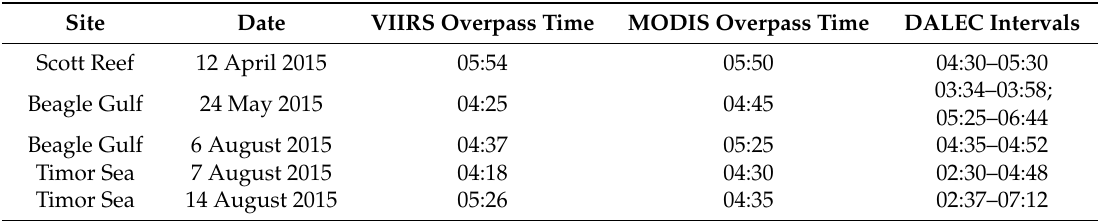
Figure 2. Study site. ( a ) Northern Australia location map for DALEC data used in this study, the green box indicates the position of image ( b ) while the red box indicates the position of image ( c ). True color images are from Moderate Resolution Imaging Spectroradiometer (MODIS) acquired on 12 April 2015 at 05:54 UTC ( b ) and on 24 May 2015 at 04:25 UTC ( c ). Contrasting dots overlaying the red and green transects identify segments of DALEC data used in matchups, as described in Section 4 and Table 1. Table 1. Satellite overpass date and times and DALEC time intervals reported in Universal Time (UTC). Site